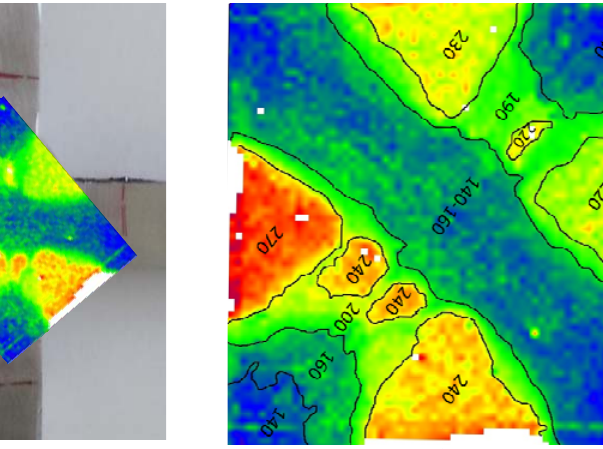
Figure 3: Different material zones. Figure 4: Hardness measurements. Figure 5: Hardness values.